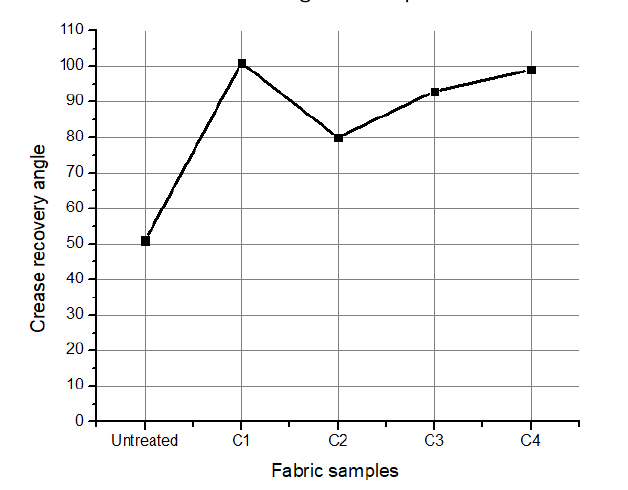
Fig. 3 . Graphical representation of (a) Elongation break (b) Tensile strength of samples